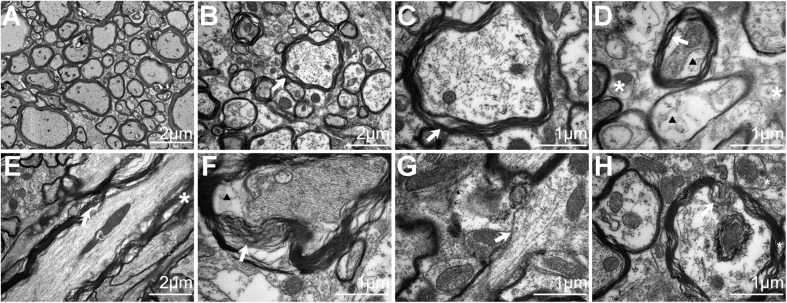
Electron microscopy analysis of traumatic axonal injury after repetitive traumatic brain injury (rTBI) in the brain stem. (A) Axons were consistently intact and organized in sham-treated mice, and mitochondria were normal in the brain. (B) A transverse section shows dystrophic myelinated axons at 24 h post injury. Focal separation of the axolemma and myelin sheaths was also observed (white arrow). (C) High-magnification cross-sectional view of (B) showed dystrophic myelinated axons and myelin sheath delamination (white arrow). (D) High-magnification cross-sectional view of injured axons; notable myelin sheath delamination (white arrow) was observed at 24 h post trauma. Focal intracellular edema (indicated by an arrowhead) and swollen mitochondria (white asterisk) were also present. (E) A longitudinal section through an injured axon (white arrow) showed more myelin sheath delamination and more cytoskeletal filaments (white asterisk) disrupted at 72 h post injury. (F) Transverse section showed axons with partial axoplasmic collapse (white arrow) and intracellular edema (arrowhead) at 72 h post trauma. (G,H) At 168 h after injury, advanced stages of axonal damage were characterized by small regions of focal myelin loss (white arrow) and intra-axoplasmic abnormal electron-dense material (white asterisk) with a longitudinal section and a transverse section, respectively.